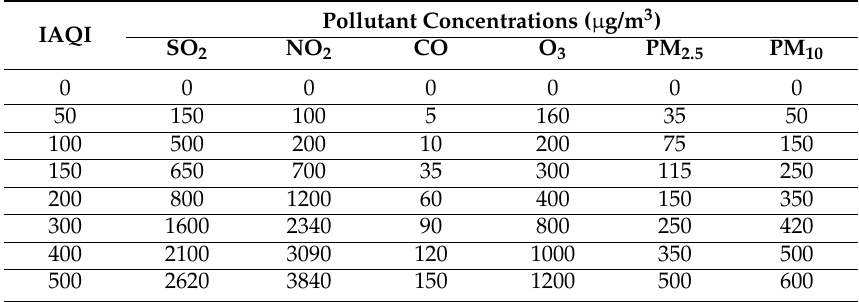
Table 2. The concentration breakpoints for each pollutant in the Air Quality Index (AQI)